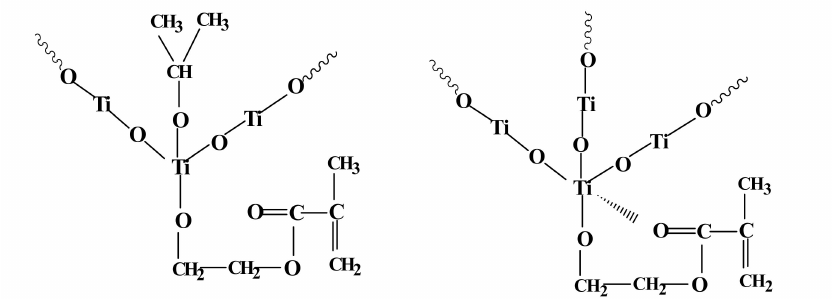
Figure 3. Possible structures of poly(titanium oxide) in HEMA obtained by varying the molar ratio Ti(OPr i ) 4 /H 2 O.